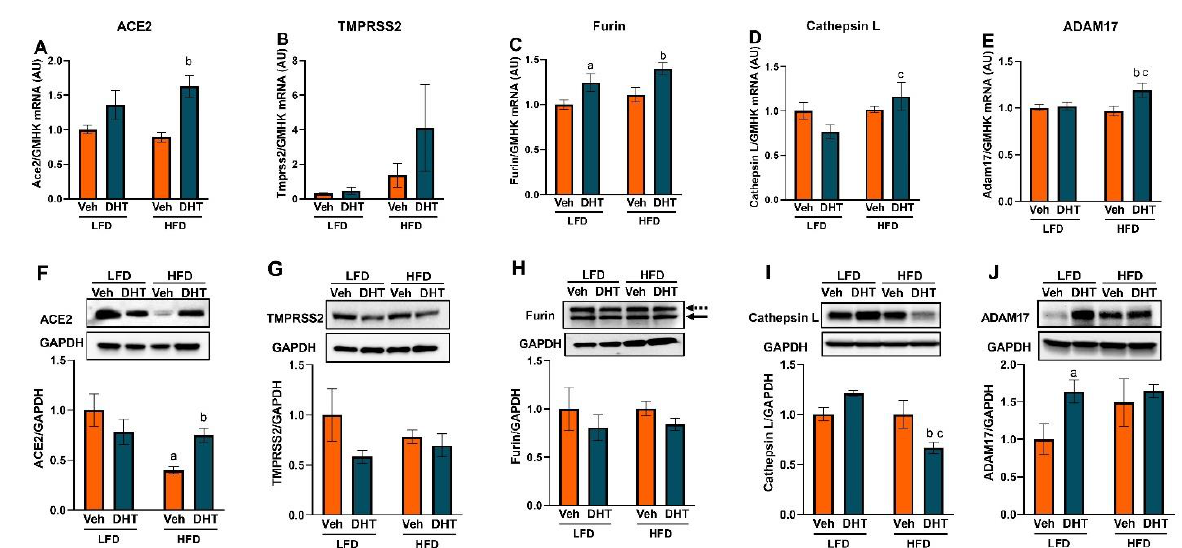
Figure 3. Effect of DHT and diet on cardiac SARS-CoV-2 viral entry proteins expression. Animals were treated with dihydrotestosterone (DHT) or vehicle (Veh) and maintained in low (LFD) or high (HFD) fat diet for 90 days. Ace2 ( A ), Tmprss2 ( B ), furin ( C ), cathepsin L ( D ), and ADAM17 ( E ) mRNA was quantified by RT-qPCR and standardized to the geometric mean of four housekeeping genes (HGMK) ( N = 6/group). ACE2 ( F ), TMPRSS2 ( G ), furin ( H ), cathepsin L ( I ), and ADAM17 ( J ) protein was quantified by Western-blot and normalized to GAPDH ( N = 4/group). Total furin ( H ) was quantified as the sum of profurin (dashed arrow) and cleaved soluble furin (solid arrow). Data are expressed as mean ± SEM. Data were analyzed by two-way ANOVA followed by Fisher’s LSD test. a p < 0.05 vs. LFD-Veh; b p < 0.05 vs. HFD-Veh; c p < 0.05 vs. LFD-DHT.